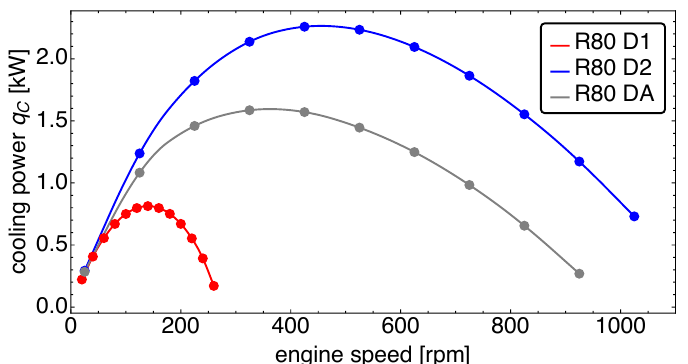
Figure 7. The cooling power for r = 0.8 regeneration extent is shown as a function of the engine speed for the three engine designs D1, D2, and DA. The cooling power for the D1 design is about one third as large as the one for the D2